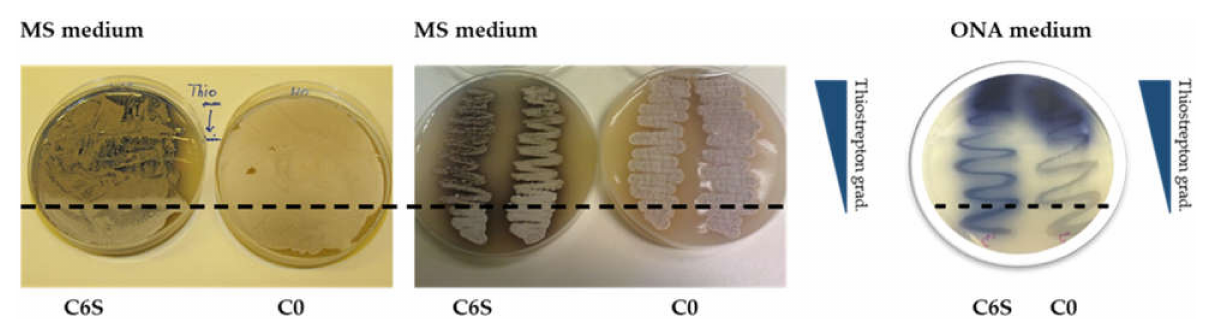
Figure 6. The C6S and C0 strains on MS and ONA medium with a linear concentration gradient of thiostrepton (0–25 µ L mL − 1 respectively to the blue wedge shown to the right of the plates) after 120 h of cultivation. The dashed line indicates where the thiostrepton gradient begins (most concentrated area is at the top of the image).